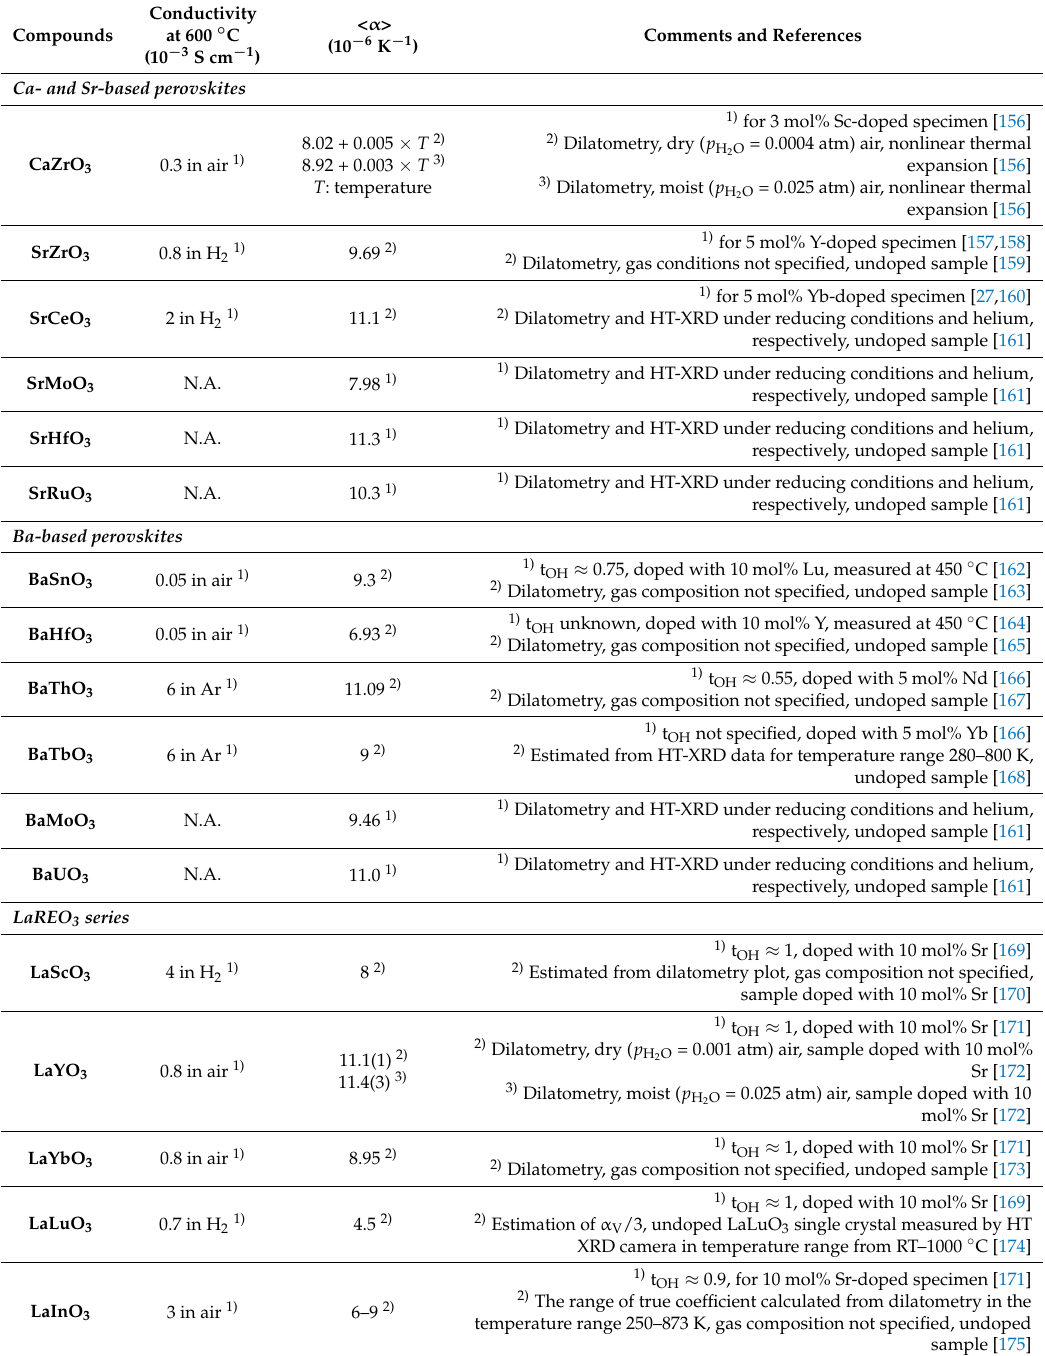
Table 3. Thermal expansion and total conductivity under wet conditions (600 ◦ C) in proton conducting perovskites other than barium cerates and zirconates. The coefficients of some other perovskites are included for completeness, although these have not explicitly been shown to conduct protons. Their conductivities are therefore denoted by